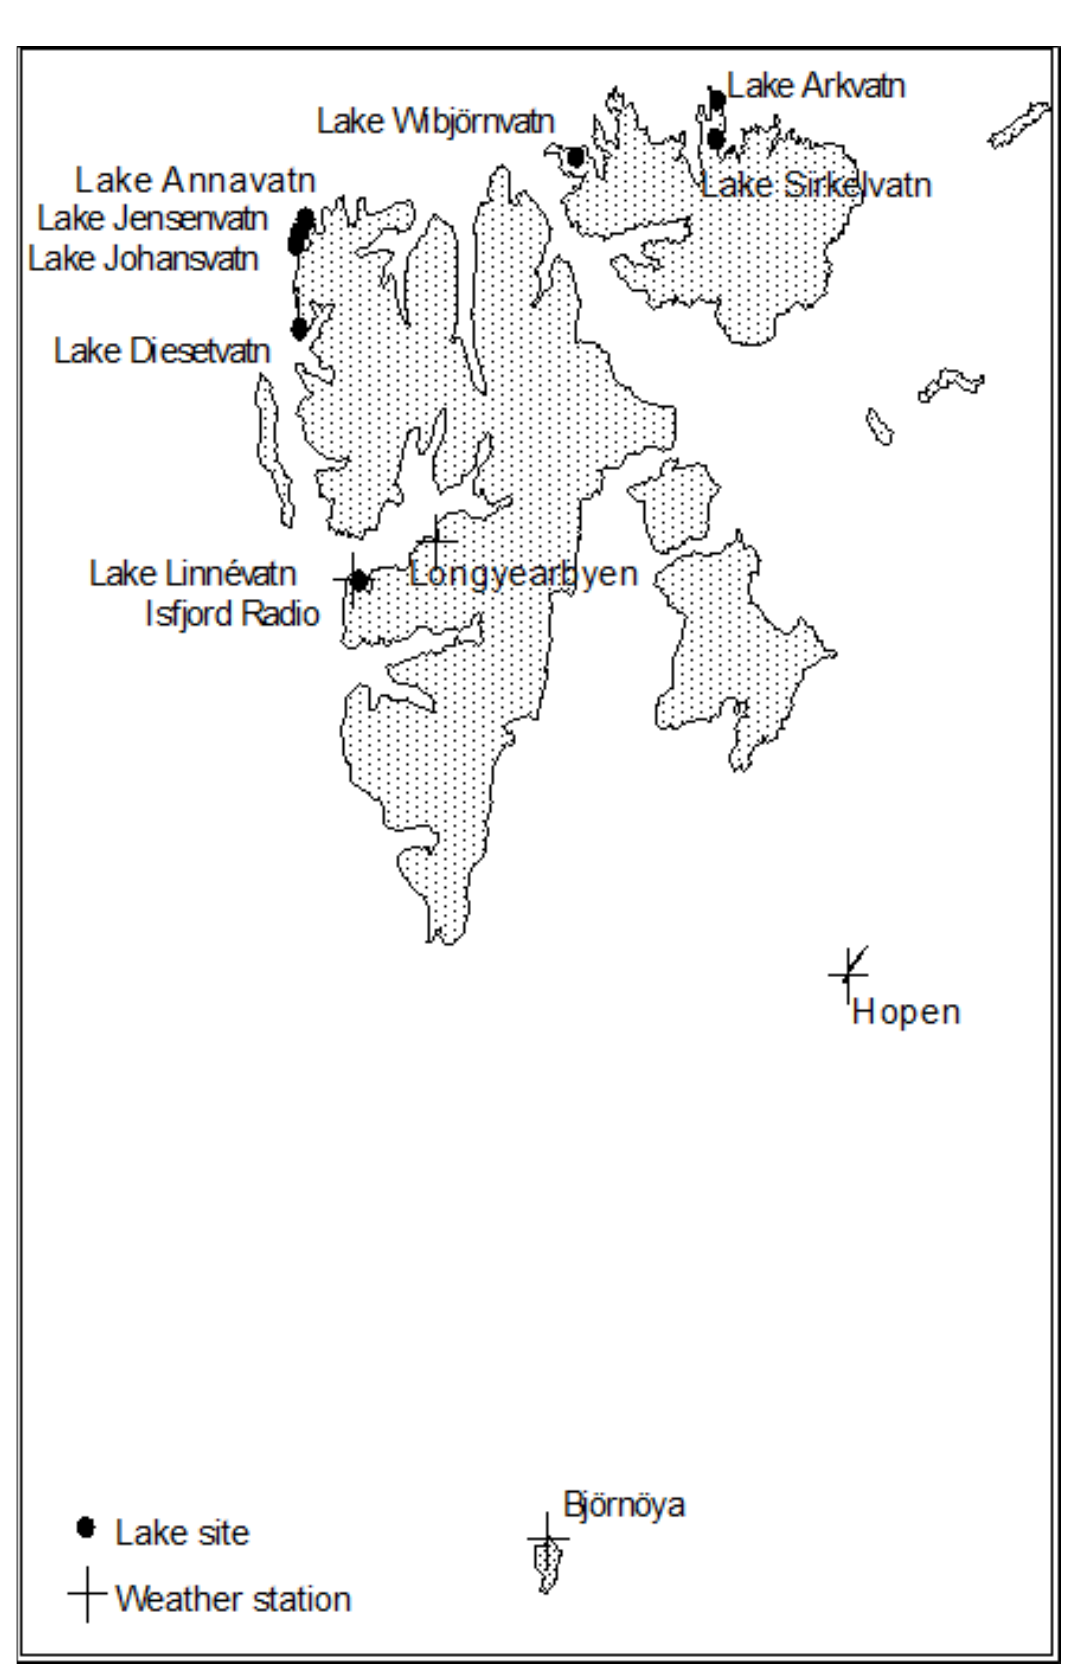
Figure 1. The geography of Svalbard at 74–81° North and 9–33° East, with sampling sites and weather stations.